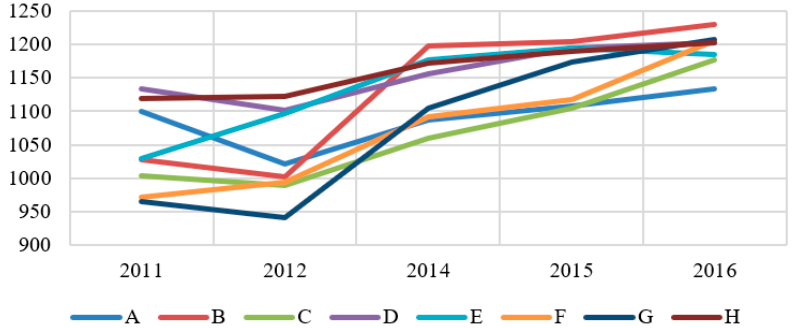
Figure 12. The average value of the rate of number of kilometres per one transport order in the Germany-bound transport in the analysed road freight transport enterprises in the years 2011–2016. The time of making a decision about fulfilling an order in the analysed enterprises between 2012 and 2016 indicated an average decrease of 40% (Figure 13).